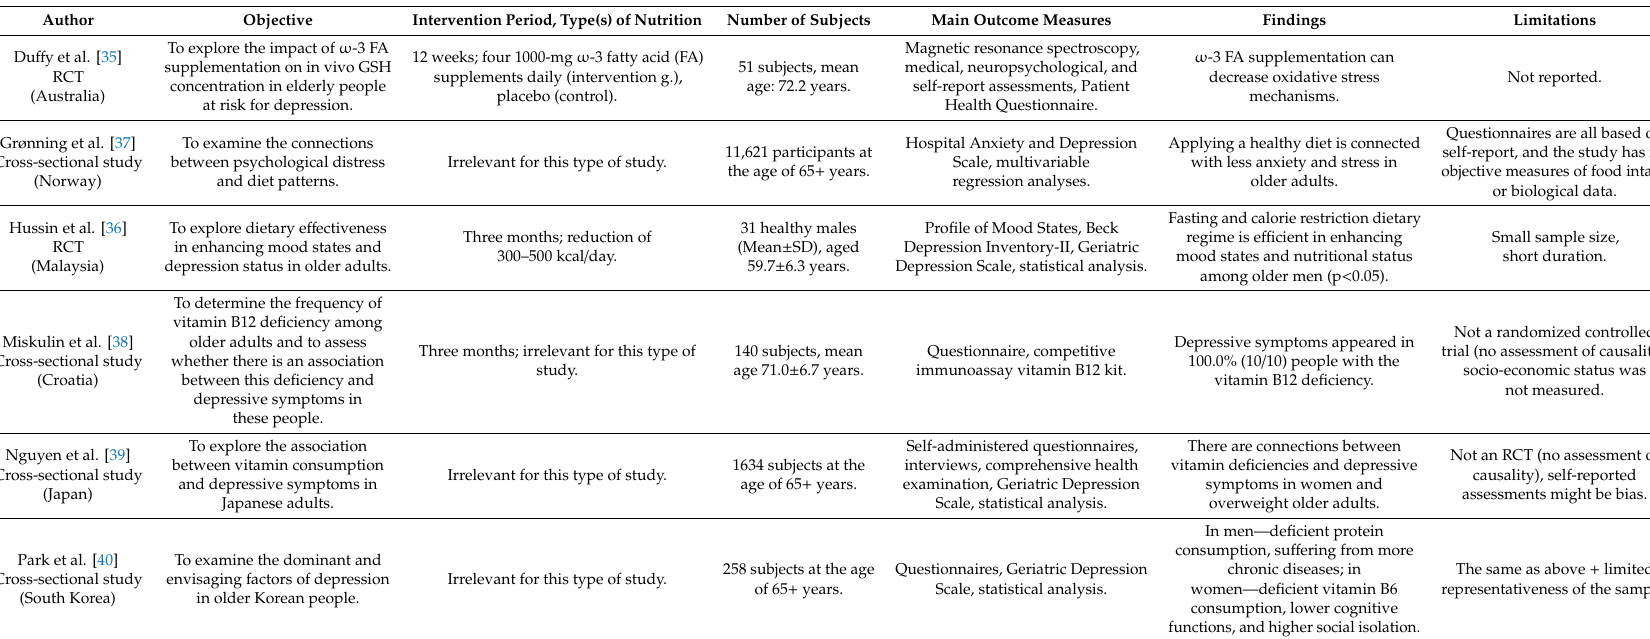
Table 1. Overview of six selected studies exploring the e ff ect of nutrition on the prevention or reduction of depressive symptoms among elderly